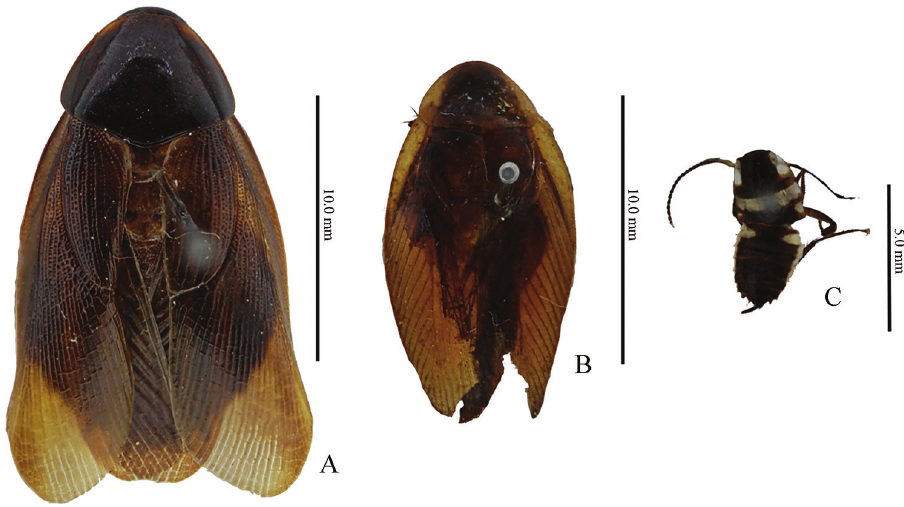
Figure 4. Other cave cockroaches from Polillo Island, Quezon: A Blaberidae: Pycnoscelus sp. D adult female B Ectobiidae: Shelfordina sp., adult female C Hemithyrsocera sp., early instar nymph.